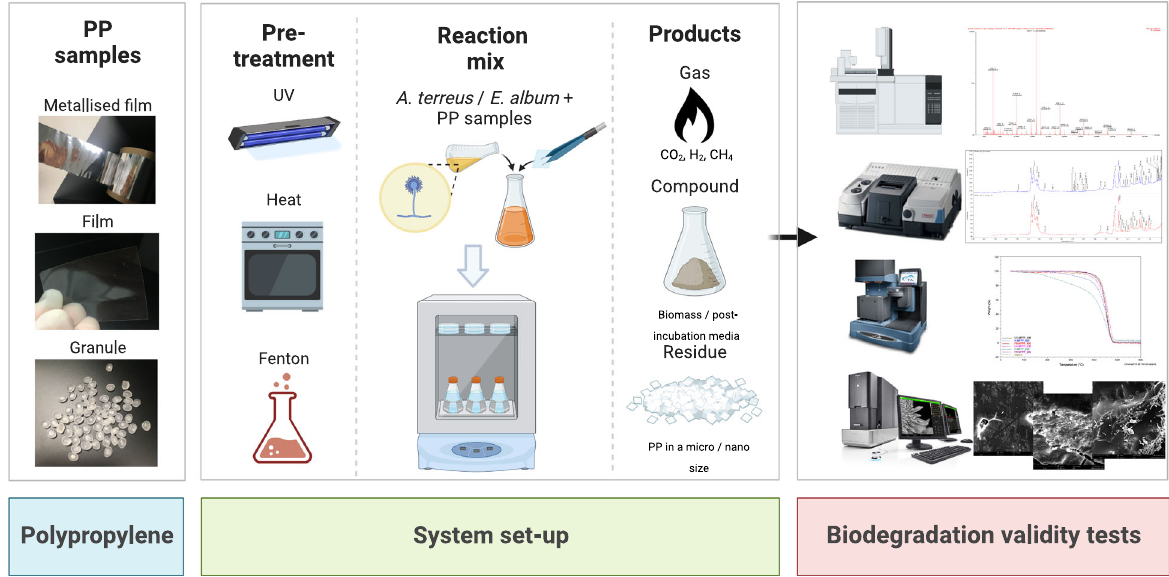
Fig. 1 Overall process of PP degradation, system, and validity tests conducted in this study. The process begins with the selection of PP samples. These samples were further pre-treated by UV, heat and Fenton ’ s chemical before feeding it to the fungi and incubating for 90 days. Post-incubation, PP residues were tested to con fi rm their degradation by GC-MS, FTIR, TGA and SEM. GC-MS and FTIR con fi rm the chemical changes, TGA determines its thermal stability, while SEM elucidates the morphological